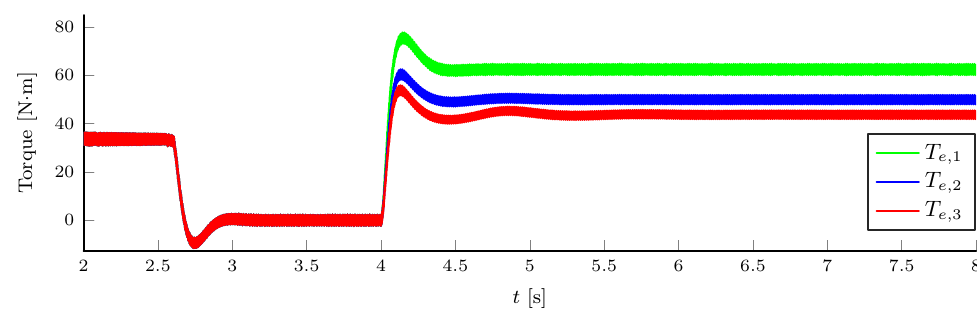
Figure 15. Electromagnetic torques; voltage-source control.